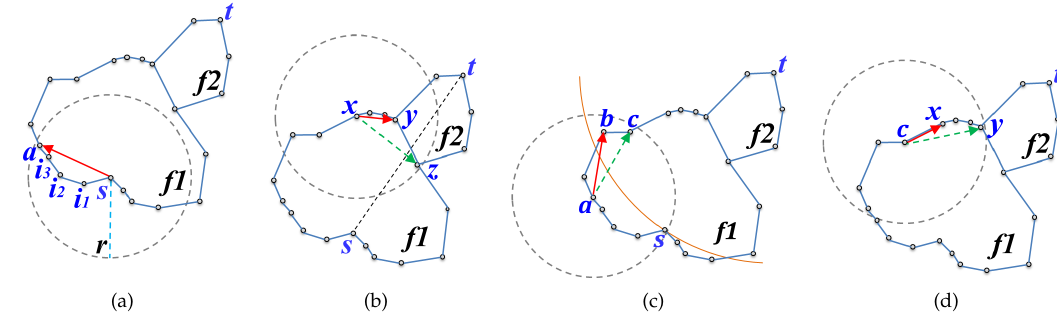
Figure 8. Four cases of node selection: ( a ) routing within the same face, ( b ) a face change occurs, ( c ) return to greedy mode, and ( d ) sequential forwarding. The arc in ( c ) signifies the distance between the destination ( t ) and node s where the face routing